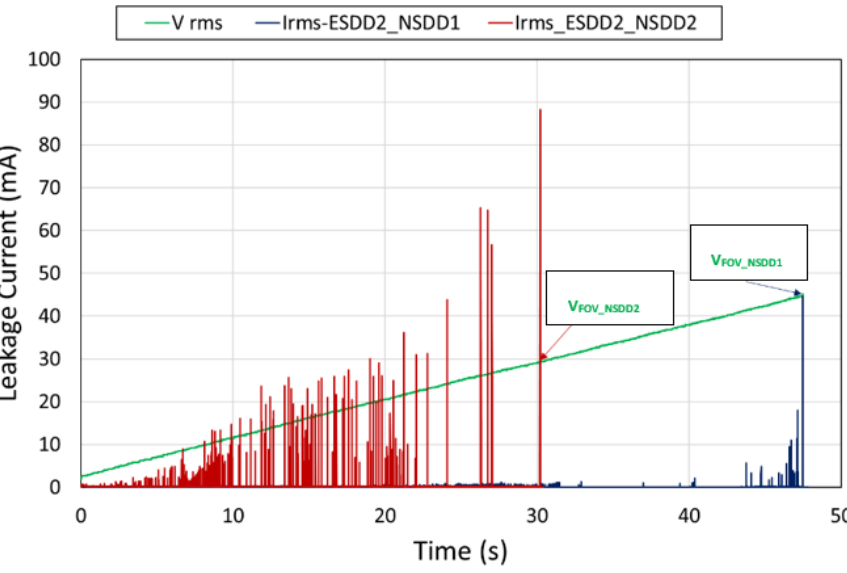
Figure 5. Leakage current and voltage during the FOV test with ESDD 2 , NSDD 1 , and NSDD 2 .